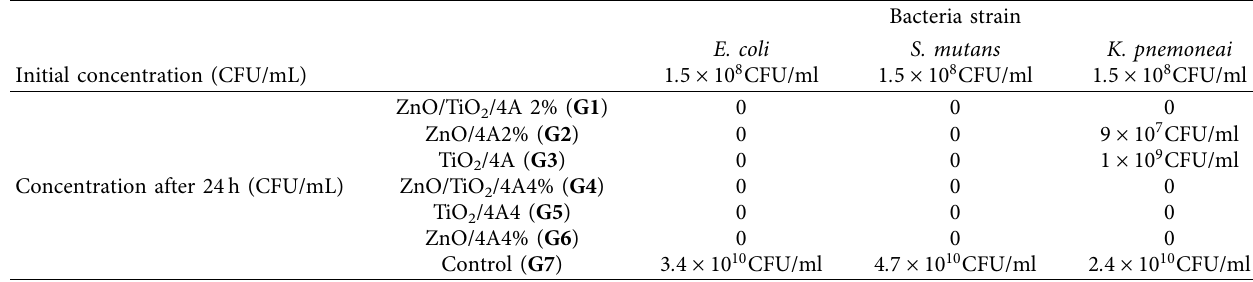
Table 2: Initial concentration and concentrations of the three bacterial strains in suspensions after 24 h of contact with differently modified samples (colony formed unit/mL).